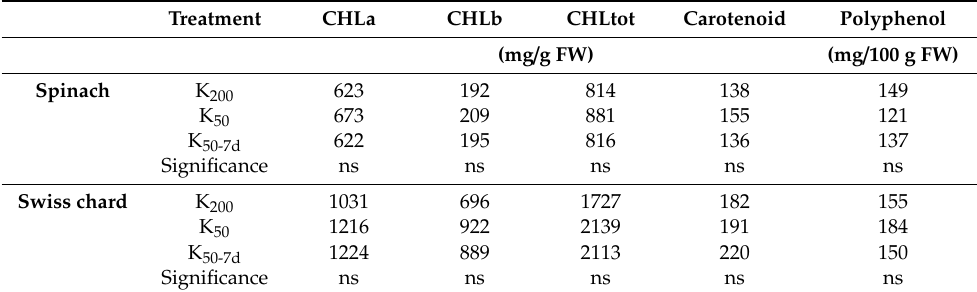
Table 3. E ff ects of potassium (K) concentration in nutrient solution (NS) and duration of K restriction on chlorophyll (CHLa, CHLb, and CHLtot), carotenoid, and polyphenol content of hydroponic spinach and Swiss chard.